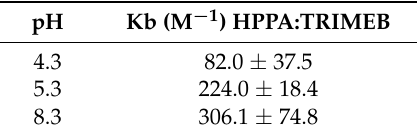
Table 1. The binding constants of HPPA:TRIMEB evaluated by absorbance measurements at different pH